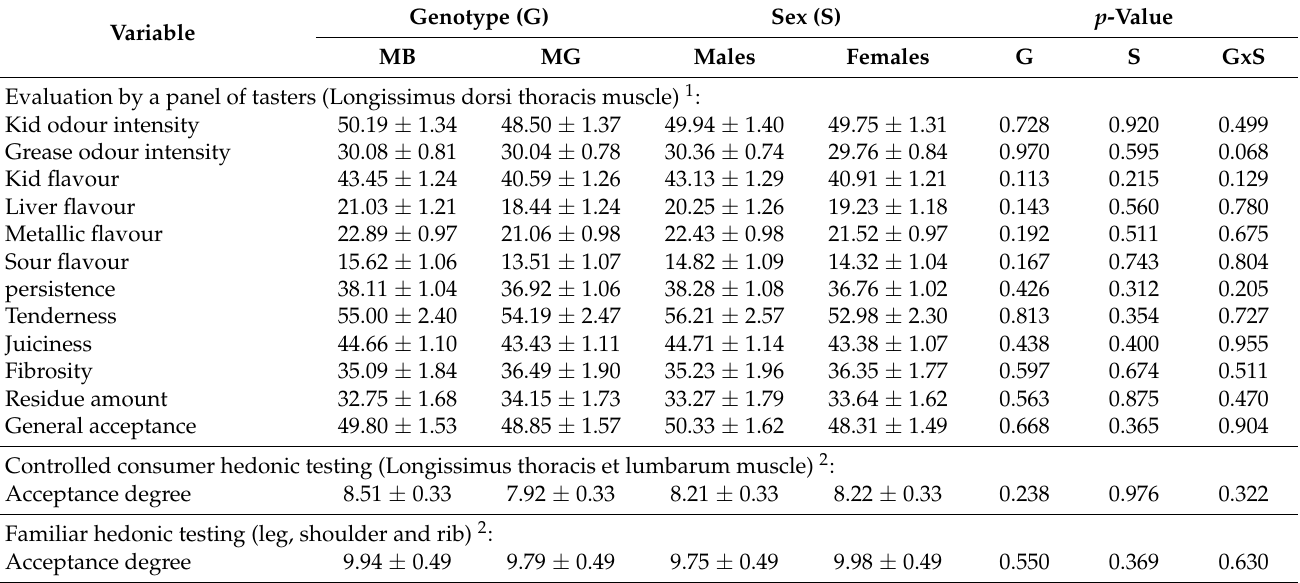
Table 6. Least-square means ( ± SE) for the sensory quality of kid meat according to genotype (purebred Murciano-Granadina (MG) or crossed with Boer (MB)) and